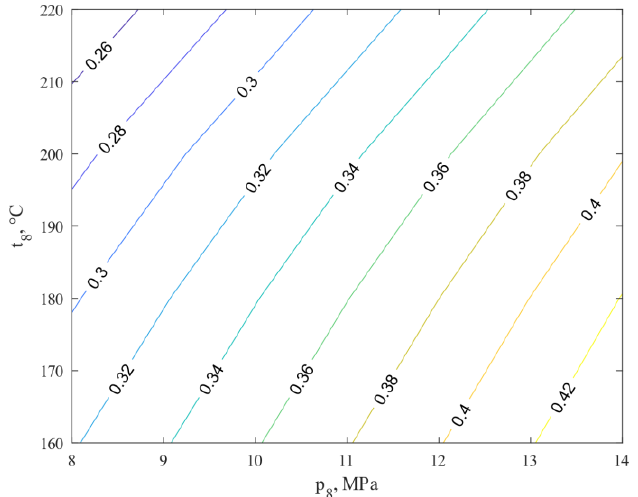
Figure 8. Influence of changes in pressure, p 8 , and temperature, t 8 , at the reactor inlet (Figure 3) on the reactor efficiency, η R .